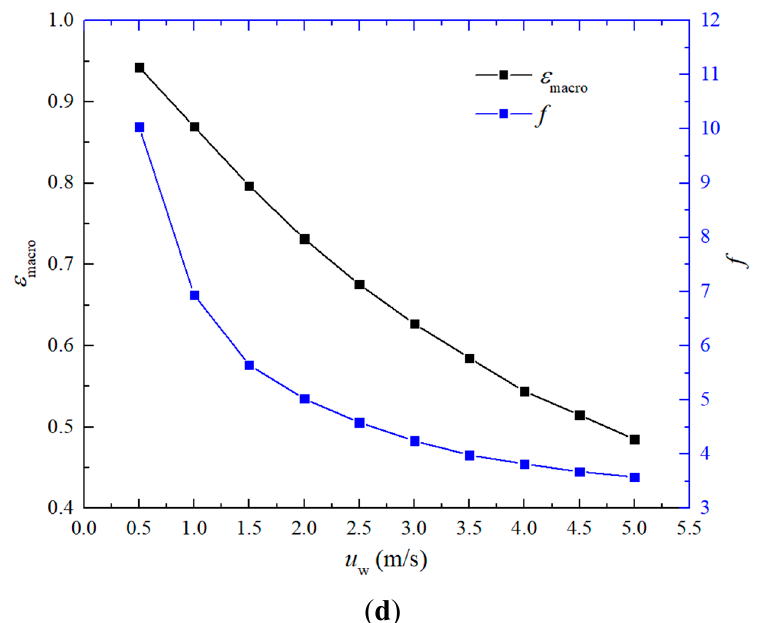
Figure 5. Experimental system for flow and heat transfer performances of finned tube bundles. ( a ) schematic diagram, ( b ) fin and finned tube bundle ( c ) experimental setup, ( d ) experimental data of friction factor and heat exchanger effectiveness.